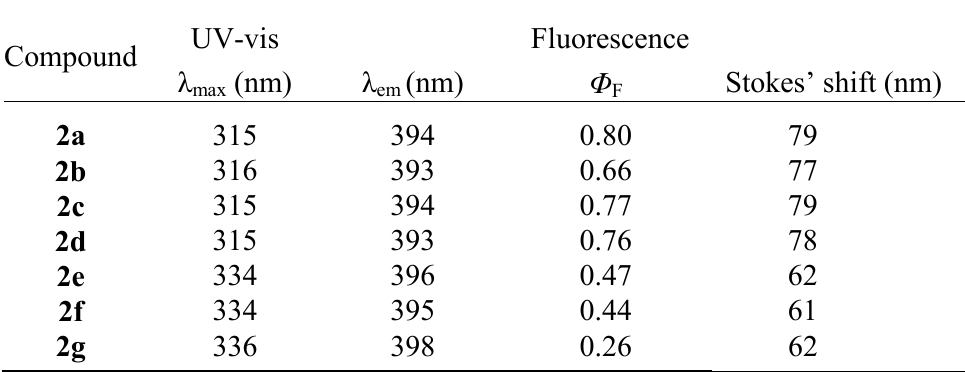
Table 2. UV-vis and fluorescence data for alanine derivatives 2a - g